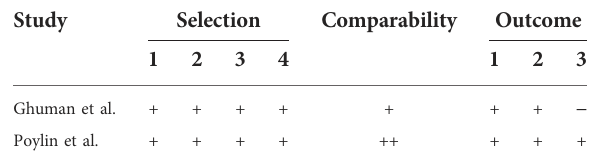
TABLE 4 Quality assessment by the Newcastle – Ottawa scale for cohort